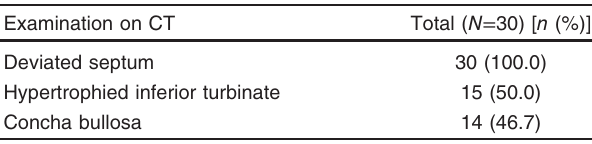
Table 1 Examination on computed tomographic distribution of the study group Examination on CT